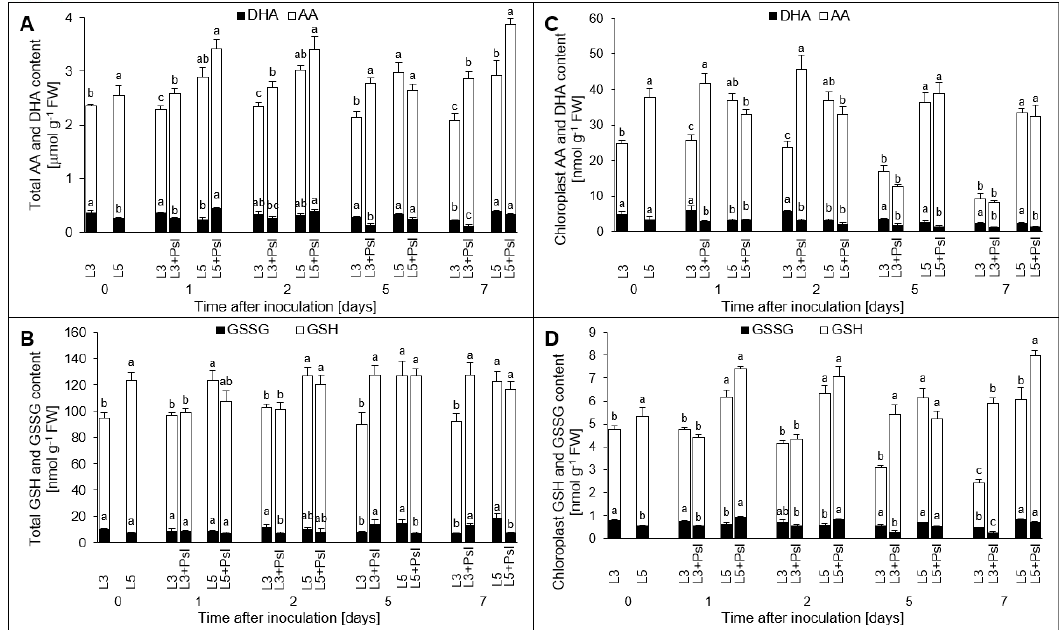
Figure 7. Ascorbate and glutathione contents. Total ( A , B ) and chloroplast ( C , D ) antioxidants contents were examined; ( A , C ) reduced ascorbate (AA) and oxidized ascorbate (dehydroascorbate, DHA); ( B , D ) reduced glutathione (GSH) and oxidized glutathione (glutathione disulfide, GSSG). Values are means of four replicates (±SD). Different letters (a – c) indicate significant ( p ≤ 0.05) differences between experimental variants within a given time point. Ascorbate and glutathione contents were calculated on fresh weight basis because Psl infection did not change relative water content of leaves and, consequently, the fresh weight to dry weight ratio.